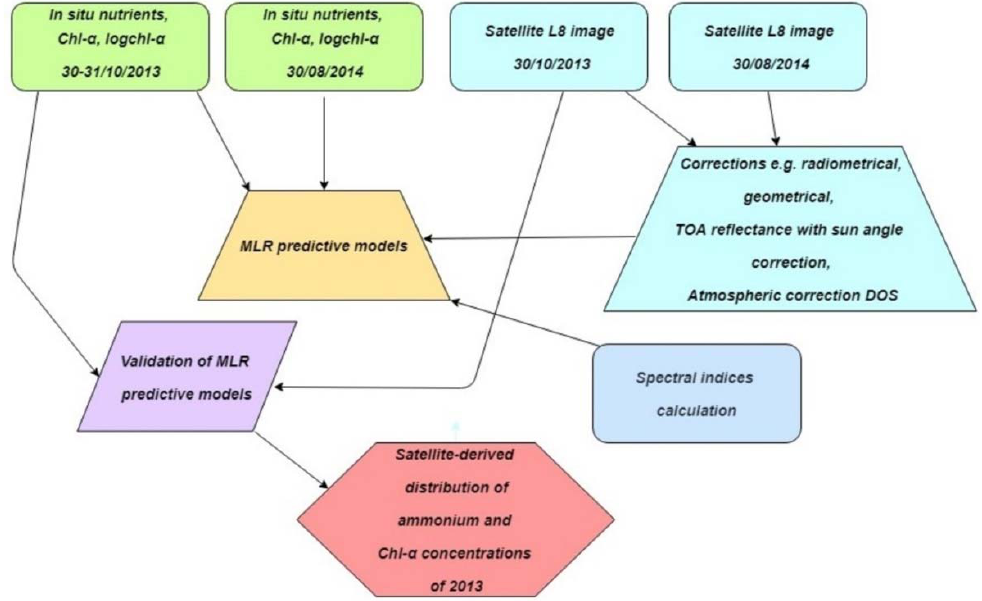
Figure 2. A flow chart summarizing the methodology adopted in this study.